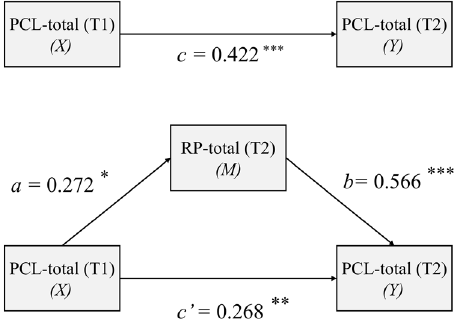
Fig. 3 Risk perception at T2 mediates the relationship between PTSD at T1 and PTSD at T2. * p value less than 0.05, ** p value less than 0.01, *** p value less than